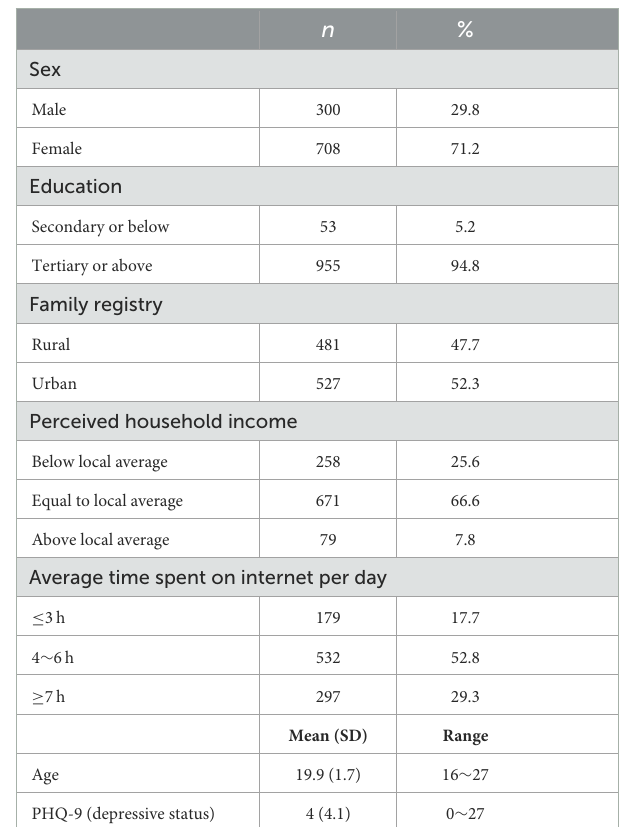
TABLE 1 Participants’ characteristics ( n =